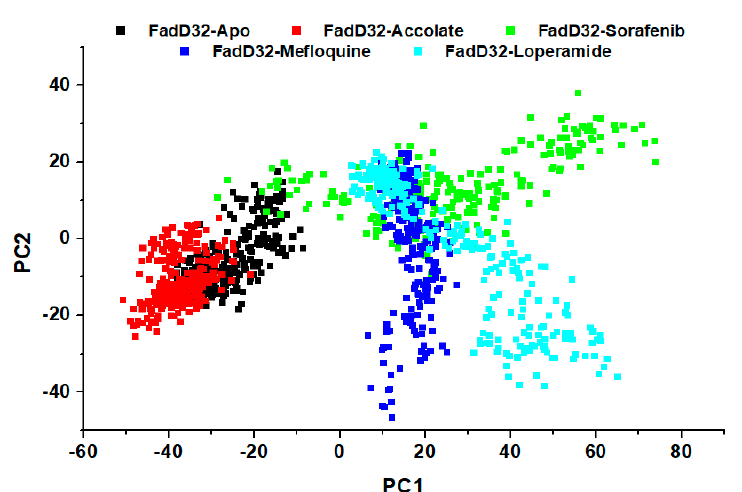
Figure 9. PCA analysis graph projecting the eigenvalues of FadD32-Apo, FadD32-Accolate, FadD32- Sorafenib, FadD32-Mefloquine, and FadD32-Loperamide along PC1 and PC2.